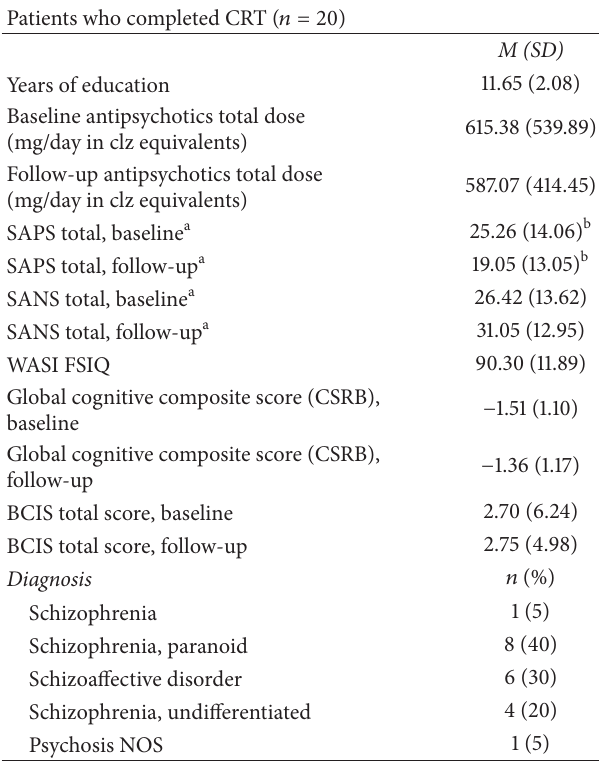
Table 2: Demographic and clinical